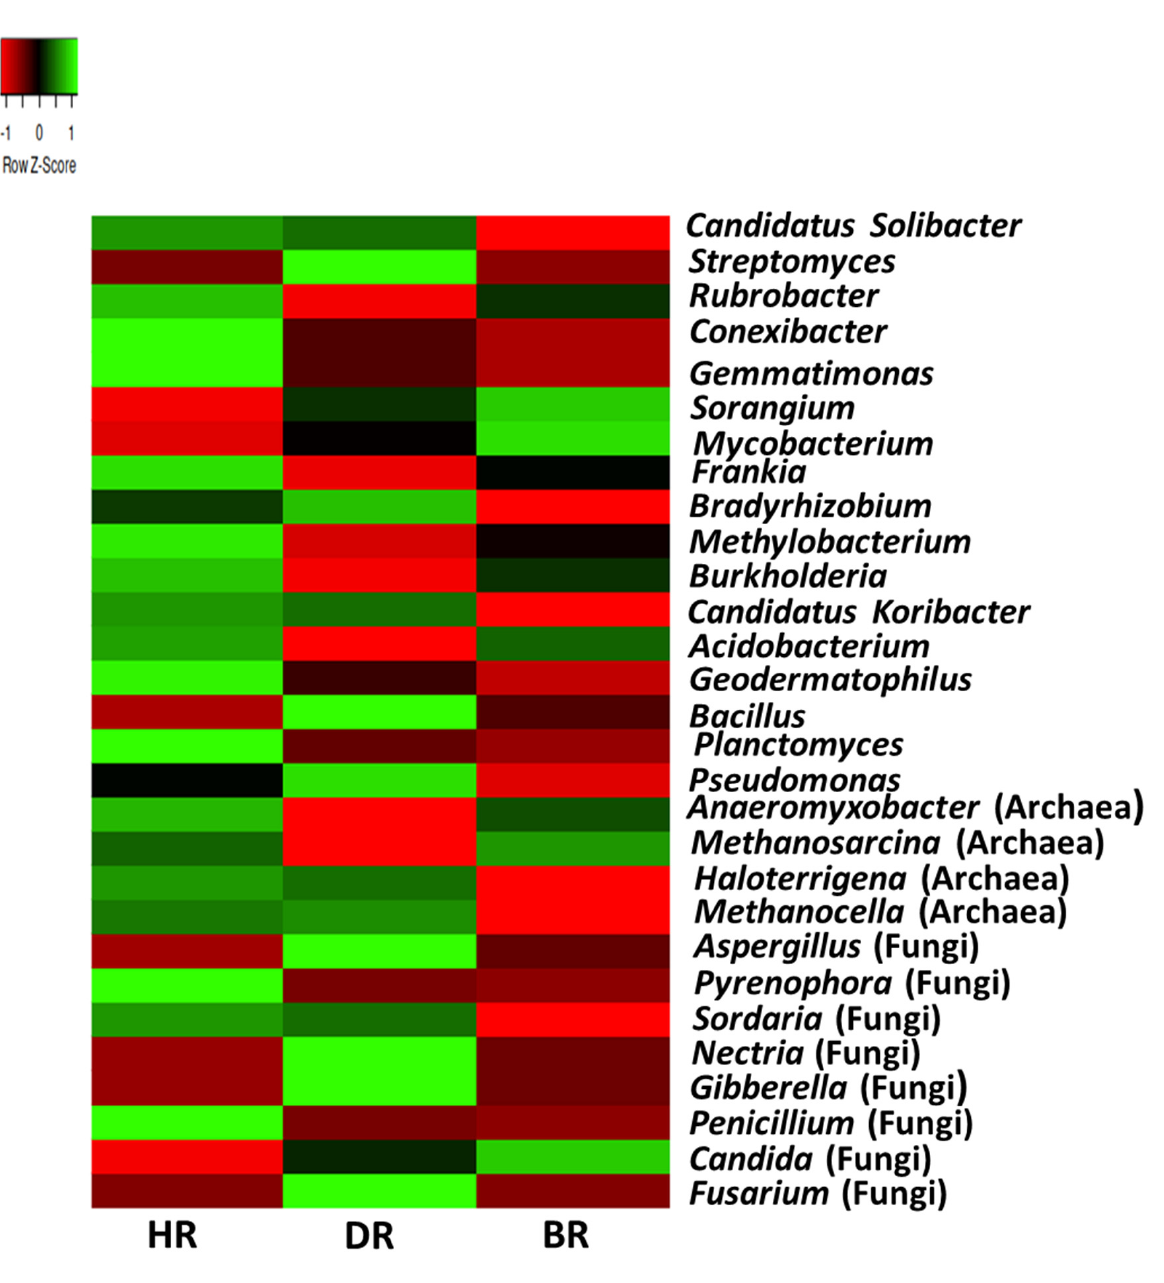
Figure 6. The genus heatmap of soil microorganisms affiliated with the tomato plants. Each plot with unique color functioned as a saturation gradient employing the mean value with a z-score. HR = rhizosphere soil of healthy tomato plant; DR = rhizosphere soil of diseased tomato plant; and BR = bulk soil obtained from the soil without tomato plantation.